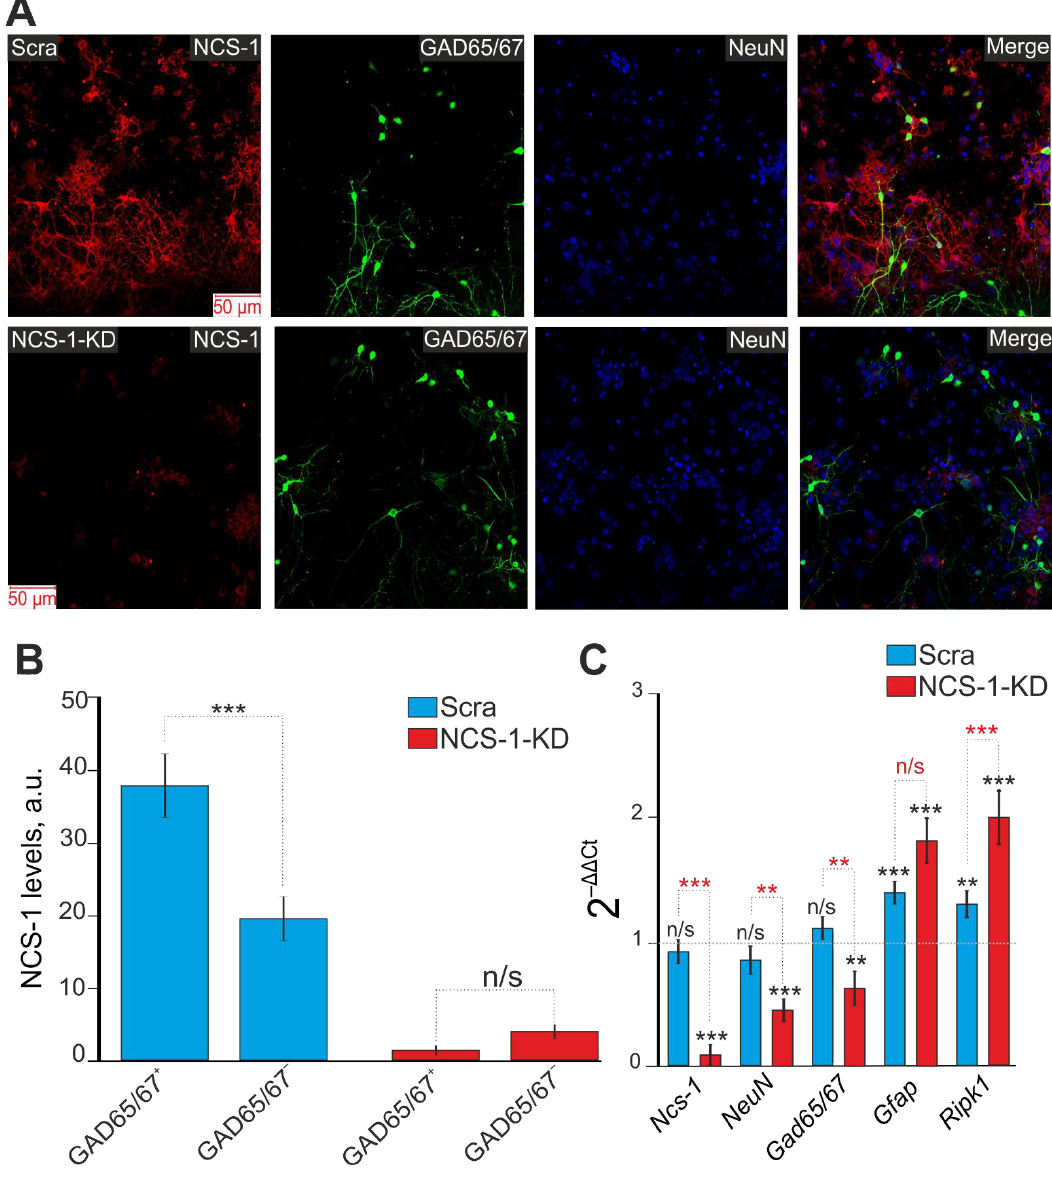
Figure 2. Effect of NCS-1 knockdown on the level of NCS-1 in GABAergic neurons and expression of genes encoding proteins-markers of neurons ( NeuN ), astrocytes ( Gfap ) and the pathway of necrotic death. ( A ) Immunocytochemical staining of a cell culture of the mouse cerebral cortex with antibodies against NCS-1, GAD65/67 and NeuN in control (Scra) and in cells with NCS-1 knockdown (NCS- 1). Merge—the overlay of antibody fluorescence. ( B ) Level of NCS-1 expression in GABAergic (GAD65/67 + ) and non-GABAergic (GAD65/67 – ) neurons of the cerebral cortex in control samples (Scra) and in cells with NCS-1-KD. Intensity levels of NCS-1 expression were determined by confocal imaging. The quantative data reflecting the level of NCS-1 expression are presented as fluorescence intensity values in summary bar charts (mean ± SEM). The values were averaged by 150 neurons for each column. We used the scans from three independent view fields for each experimental group. Statistical significance was assessed using paired t-test. ( C ) Level of gene expression in Scra and NCS-1-KD samples in mouse cortex cells. Gene expression in control cells (without exposure to lipofectamine and shRNA) are marked by dashed line. Comparison of experimental groups regarding control: n/s—data not significant ( p > 0.05), ** p < 0.01 and *** p < 0.001. Comparison of experimental groups relative to each other is indicated in red. The number of RNA samples is 3. N (number of animals used for cell cultures preparation) =